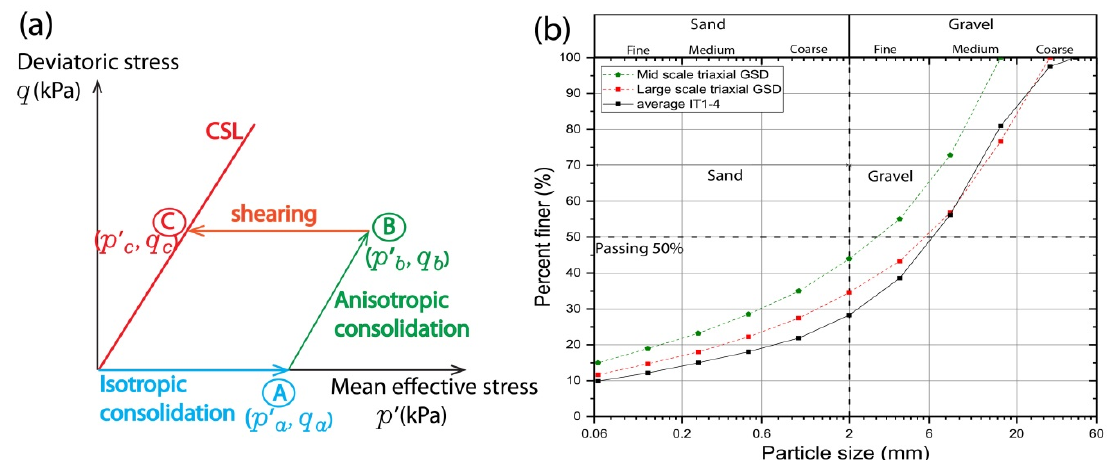
Figure 5. ( a ) Constant shear stress drained path (CSD). A is the point at the transition from isotropic to anisotropic consolidation, and B symbolises the transition from the latter to shearing as pore water pressures increases. Failure occurs at C, after shearing at constant deviatoric stress. ( b ) Grain size distribution (GSD) of the sandy gravel specimen: mid-scale (150 mm diameter) and large scale (250 mm diameter) and the average GSD of the IT1-4.